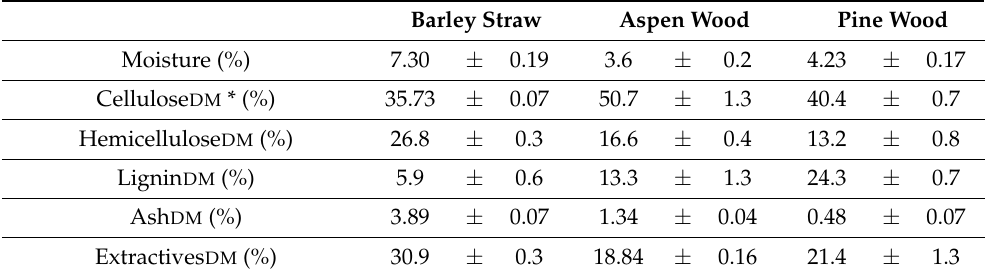
Table 1. Biomass characteristics of untreated barley straw, aspen wood, and pine wood. The values are given in percentage and represent the mean with corresponding standard deviation. All values are given on a dry matter basis, except the moisture content. Barley Straw Aspen Wood Pine Wood Moisture (%) 7.30